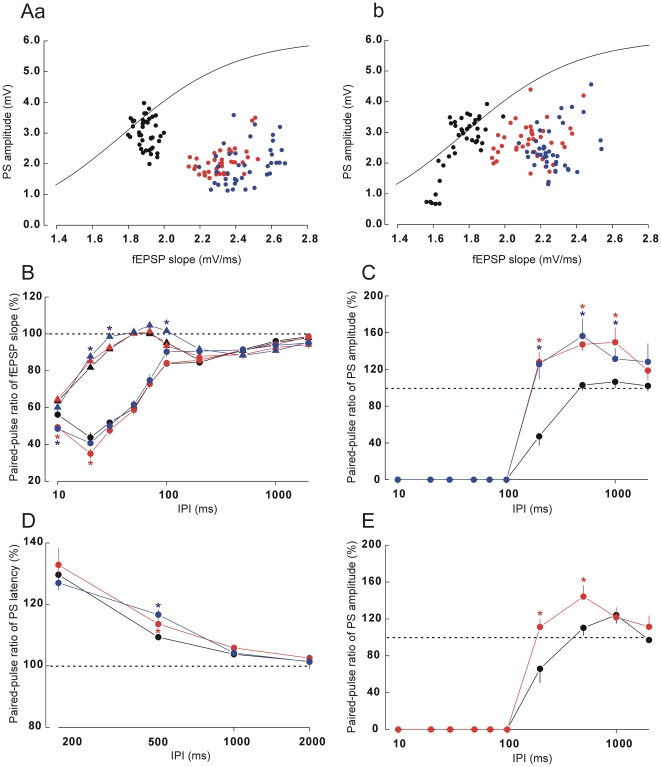
Influence of diazepam on paired-pulse responses.A: relationships between fEPSP slopes and PS amplitudes in response to the first (a) or second (b) stimulation pulses under control and treatment (low-dose and high-dose diazepam) conditions. Curve lines, a part of the sigmoid fitting line shown in Fig. 1C, which is calculated from the data on stimulus intensity-response relationship. B: paired-pulse ratios for fEPSP slopes at low (triangles) or high (circles) stimulus intensity as a function of IPIs. C, D and E: paired-pulse ratios for PS amplitudes (C), PS latencies (D) and PS amplitudes of balanced data subsets (E), respectively, as a function of IPIs. The subsets of data in E were extracted so that 1stPS amplitudes were comparable between the control and low-dose diazepam conditions. Black, red and blue symbols in each panel indicate data acquired under control, low-dose diazepam and high-dose diazepam conditions, respectively. Asterisks, p<0.05 in Dunnet pairwise comparisons after one-way ANOVA in B–D, and p<0.05 in one-way ANOVA in E. Other descriptions as for the Figs. 1 and 2.